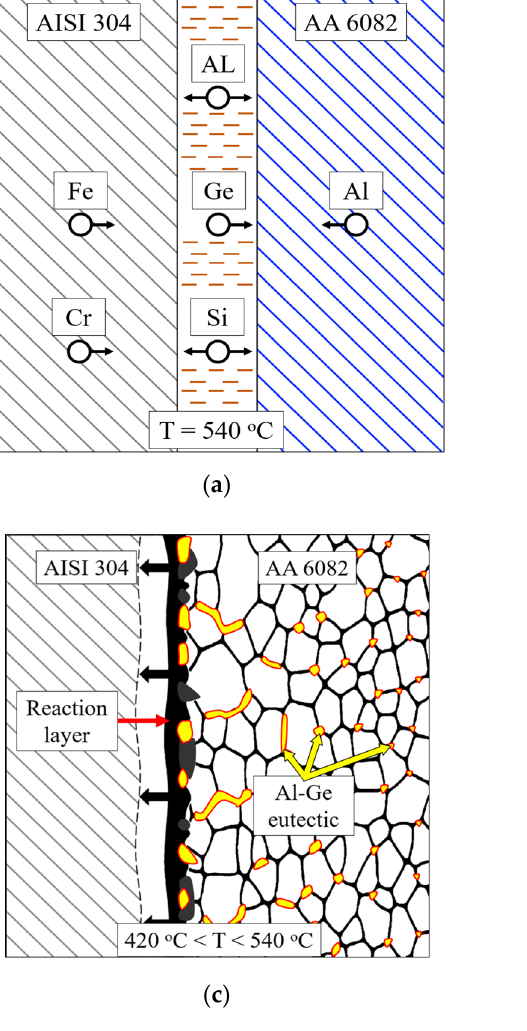
Figure 16. Scheme of the AISI 304/AA 6082 joint formation: ( a ) initial structure; ( b ) formation of the seam; ( c ) growth of the reaction layer; ( d ) final structure.